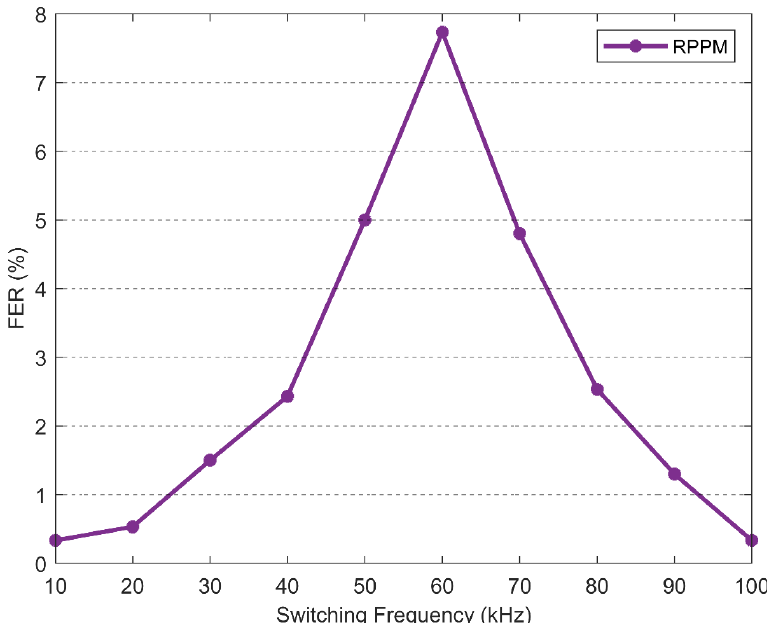
Figure 6. FER of the G3 PLC vs. switching frequency of the DC ‐ DC converter modulated with RPPM. A similar analysis involving RFM was carried out in [14], with the same input voltage of the DC ‐ DC converter (50 V), and switching frequency varied from 50 to 75 kHz. Some of the results obtained in [14] are summarized in Table 3. The comparison allows appre ‐ ciation of the fact that RFM (with 15–30% modulation index) causes significantly larger FER (more than 40%) compared to RPPM, with a maximum FER of 8% obtained at 20% modulation index (which is the maximum possible pulse position variation, as defined in (9)) around the intermediate switching frequency (60 kHz). Even with lower modulation indexes, RFM causes higher FER than RPPM. This is because the bandwidth of the noise generated by a DC ‐ DC converter with RFM is wider (i.e., the noise is more spread) than with RPPM. This can be easily appreciated in Figure 7, where the CE exiting the same DC ‐ DC converter driven by different modulation schemes (PWM, RFM, and RPPM at the 20 kHz switching frequency) are compared. The comparison unveils that even if RFM is more effective than RPPM for EMI reduction, RPPM offers significant advantages in terms of coexistence with communication systems. Of course, better performance of RFM can be obtained by adjusting the working parameters, i.e., by reducing the modulation index of RFM it is possible to have lower interference to the G3 ‐ PLC, but with lower CE reduction. This corroborates the conclusion that choosing the right modulation scheme is to be in ‐ tended as a trade ‐ off between EMI reduction and the coexistence issue. Table 3. Comparison of the performance of G3 ‐ PLC assessed with RFM and RPPM applied to the DC ‐ DC converter [14]. Frequency ( kHz )